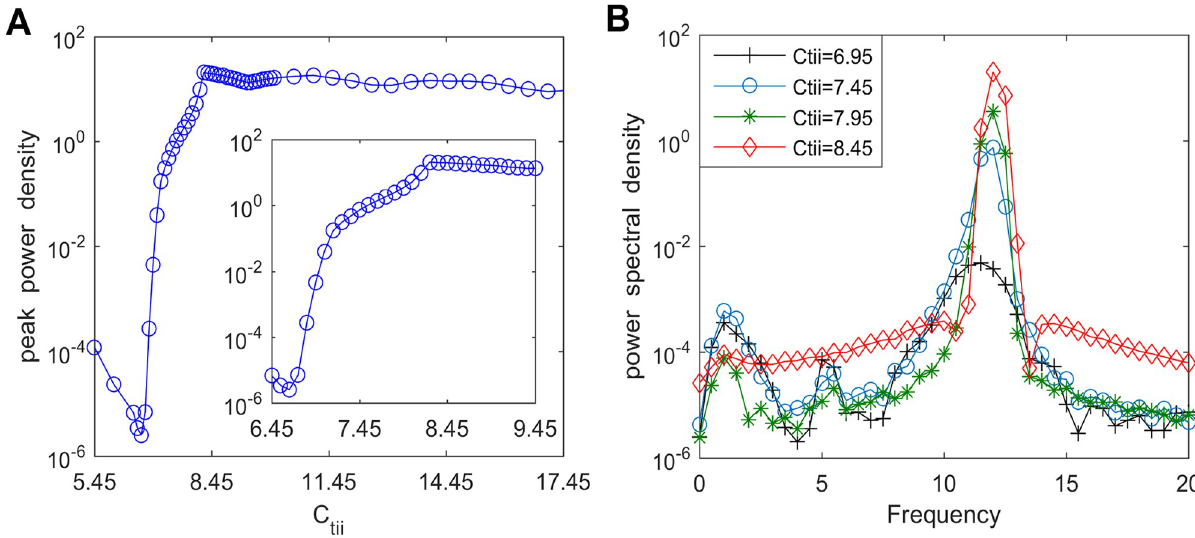
Fig 12. The peak power density and the corresponding power spectral density for varying values of C tii . (A) The peak power density within the alpha band of the thalamic output. (B) The corresponding power spectral density for different connectivity parameters such as C